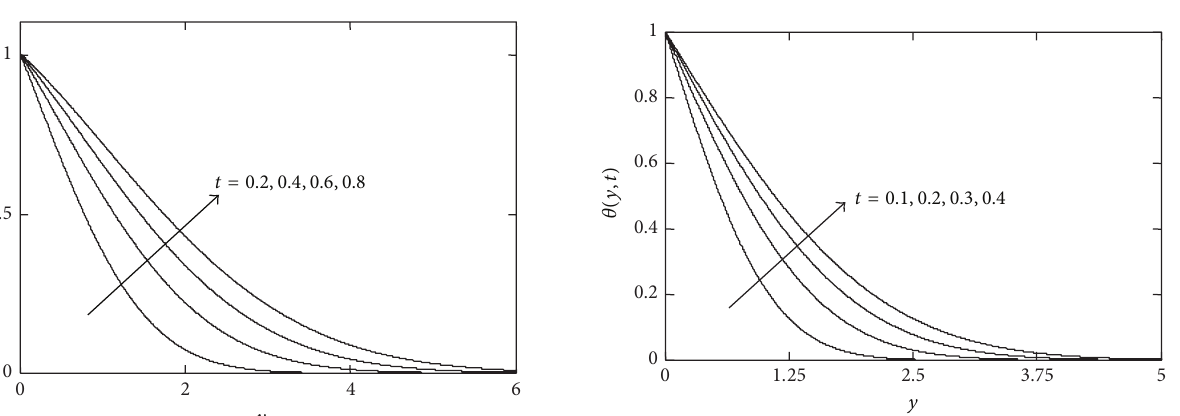
Figure 7: Profiles of velocity for different values of 𝑡 , when Pr = 0.3 , Gr = 3 , 𝛾 = 0.5 , and 𝜔 = 0 .